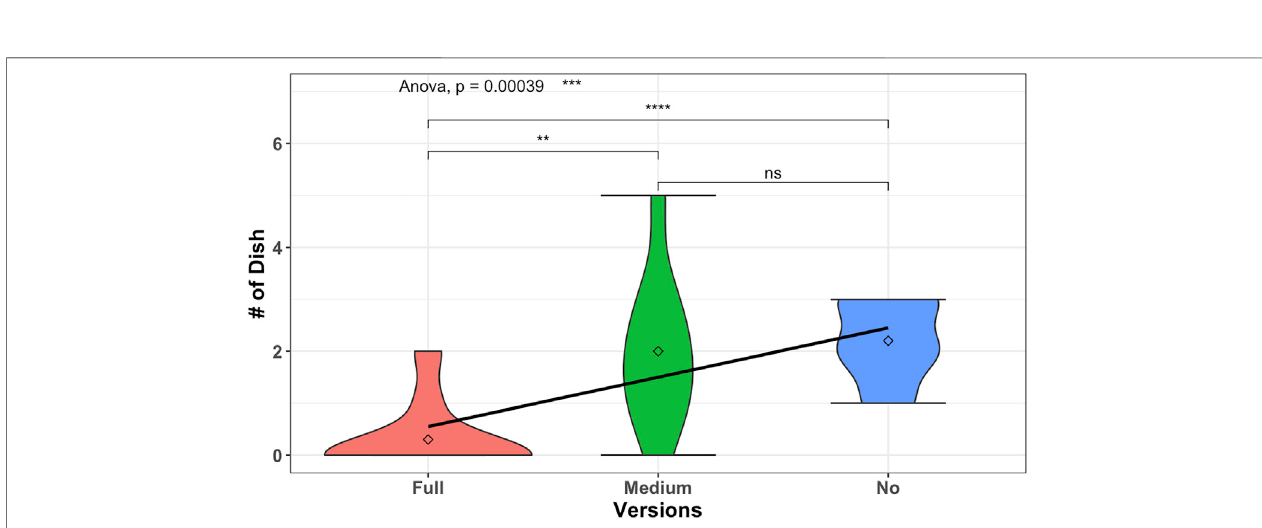
FIGURE 7 | Comparison results of creating new recipe to the effects of different versions of robot behavior to be creative on creating new recipes. It clearly shows that the balanced proactivity (version of medium proactive robot) is supporting a greater number of new recipes to be created by the users.